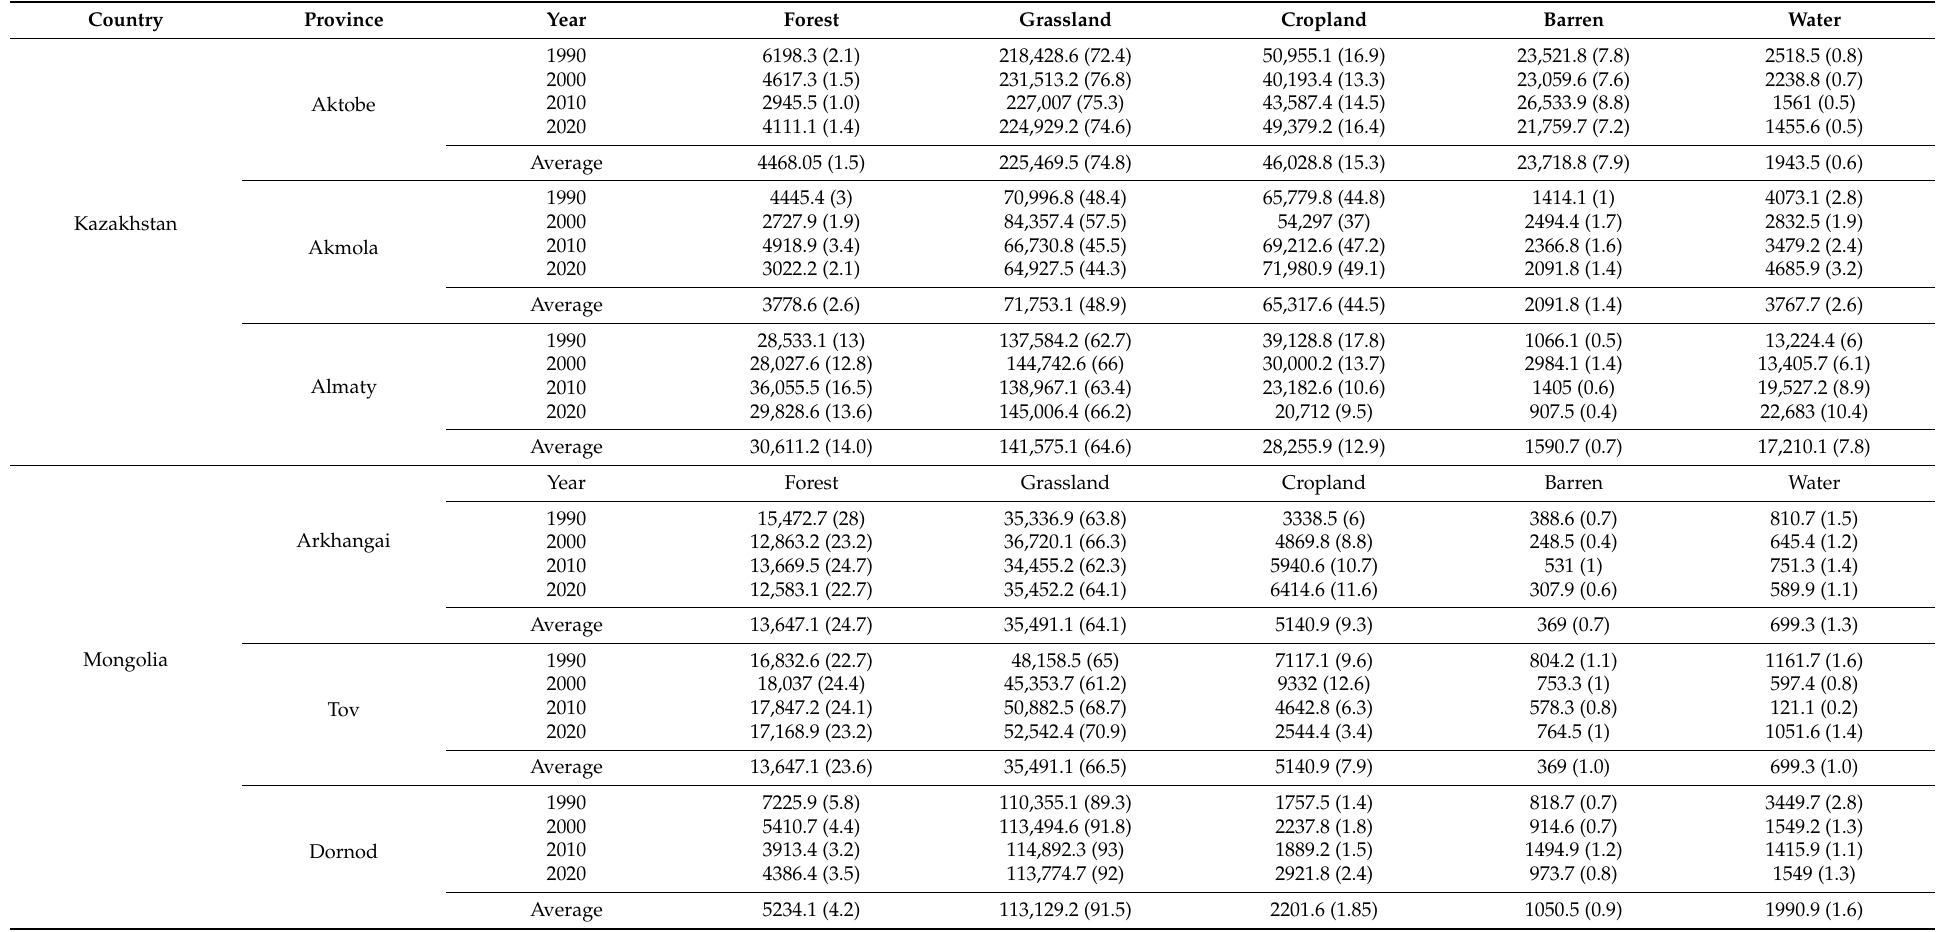
Table 2. Area (percentage) of land cover changes for the six provinces of Kazakhstan and Mongolia during the 1990s-2020s. The unit for area is km 2 ; the average values are calculated from the four time